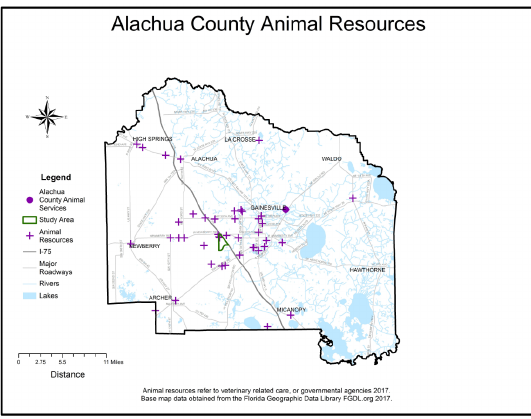
Figure 5. Alachua County Veterinary and Governmental Animal